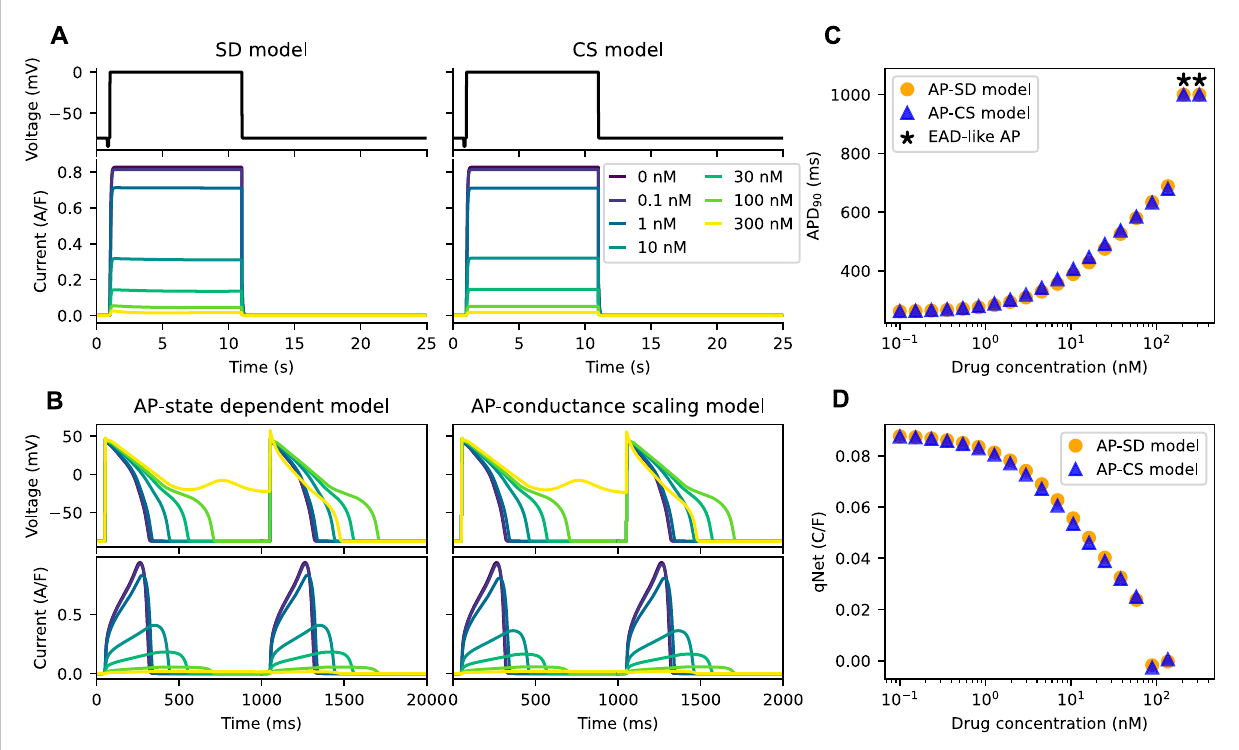
FIGURE 3 The AP-CS model can provide a reasonable approximation of the AP-SD model for an example drug T. (A) The matching of the peak hERG currents simulated by both drug block models under Milnes ’ protocol (top row) at various drug concentrations of an example drug T. (B) The AP ( fi rst row) and its hERG current (second row) for the AP-SD model and the AP-CS model at steady state. (C) The APD 90 values of the AP-SD model and the AP-CS model undertheeffectofexampledrugT.APsthatshowEAD-likebehaviourareindicatedwithanasterisk. (D) TheqNetvaluesoftheAP-SDmodelandthe AP-CS model under the effect of example drug T. qNet values of APs with EAD-like behaviours are not